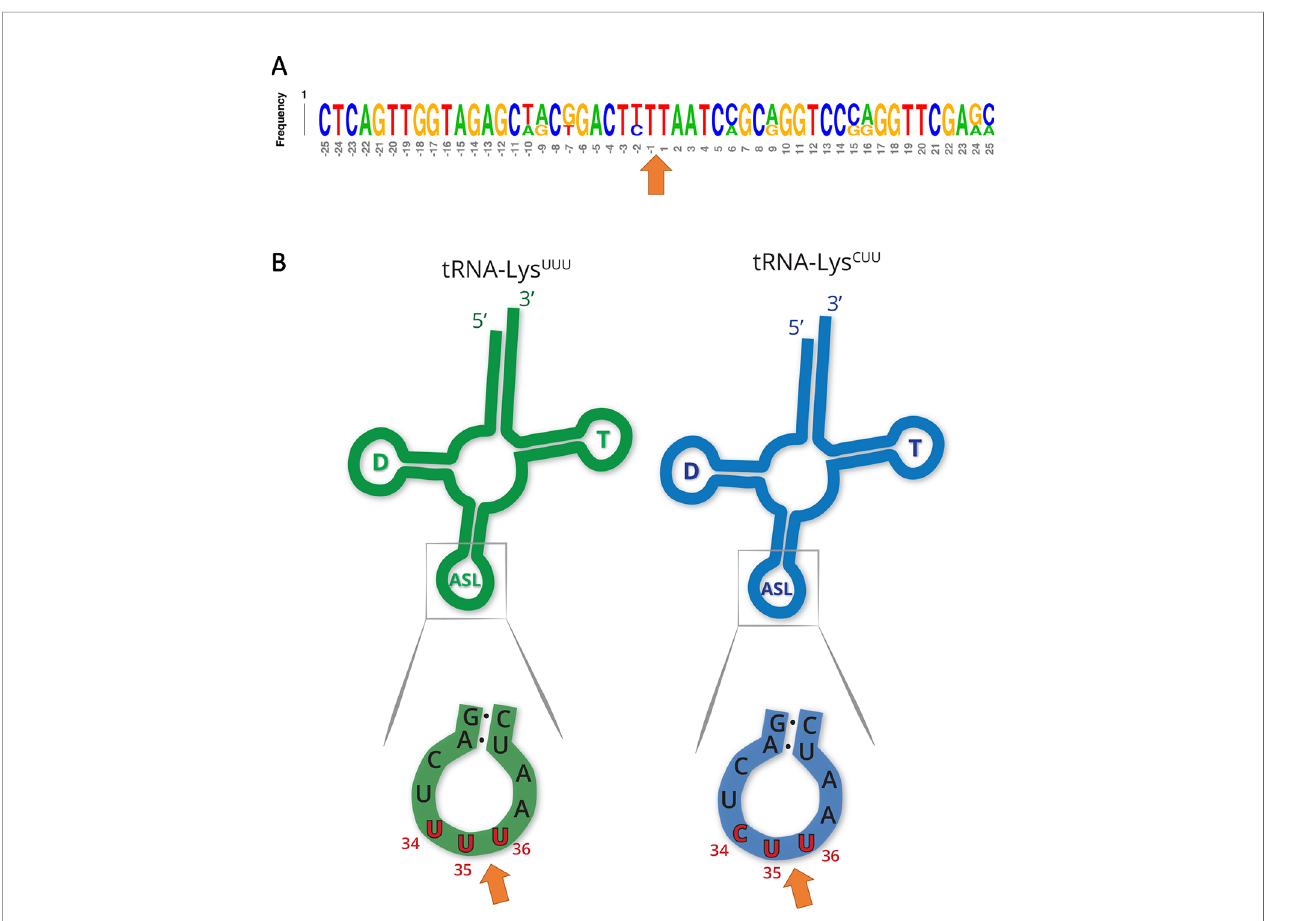
FIGURE 3 | MazF-ms targets show high secondary structure and sequence similarity. (A) Frequency logo showing the DNA sequence similarity between tRNA Lys-UUU and tRNA Lys-CUU genes in the 50 nucleotides surrounding MazF-ms cleavage position (orange arrow). (B) Schematic representation of tRNA Lys-UUU and tRNA Lys-CUU , illustrating the D-arm (D), T-arm (T) and anticodon stem loop (ASL) portions of the tRNA. ASL is partially shown in greater detail to emphasize the sequence and secondary structure near the cleavage site (orange arrow). Numbering in red indicates the nucleotide position of the anticodon in the mature tRNA